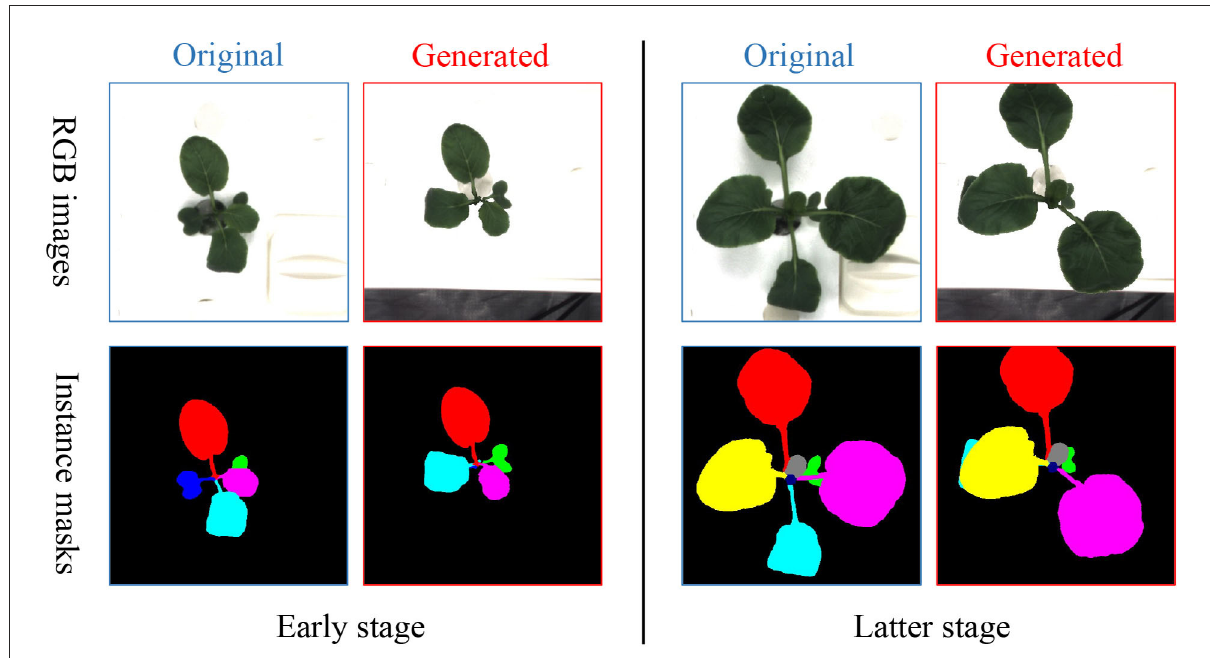
FIGURE6 Examples of images and masks generated from T-Copy-Paste with leaf-based